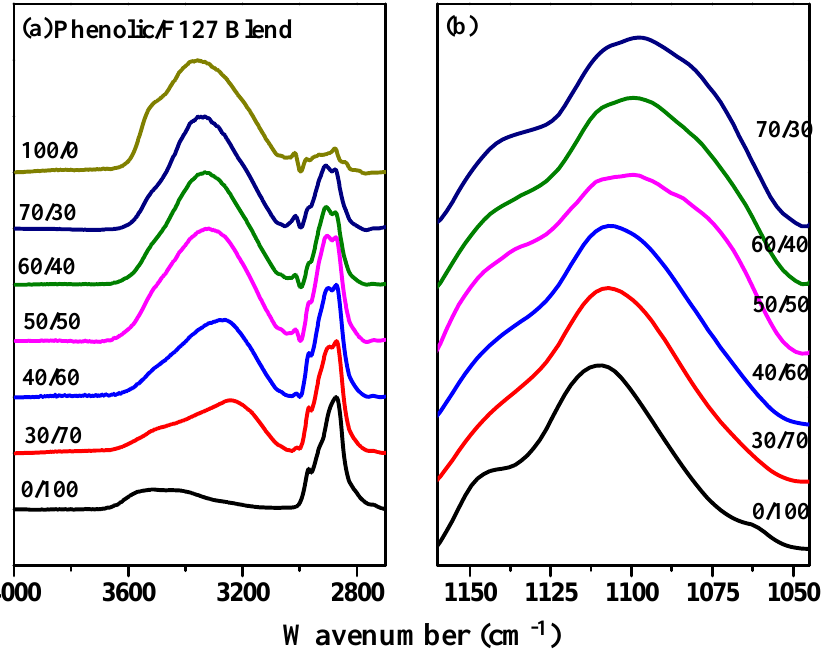
Figure 3. FTIR spectra, recorded at room temperature, of phenolic/F127 blends at various compositions: ( a ) O–H and ( b ) C–O–C stretching